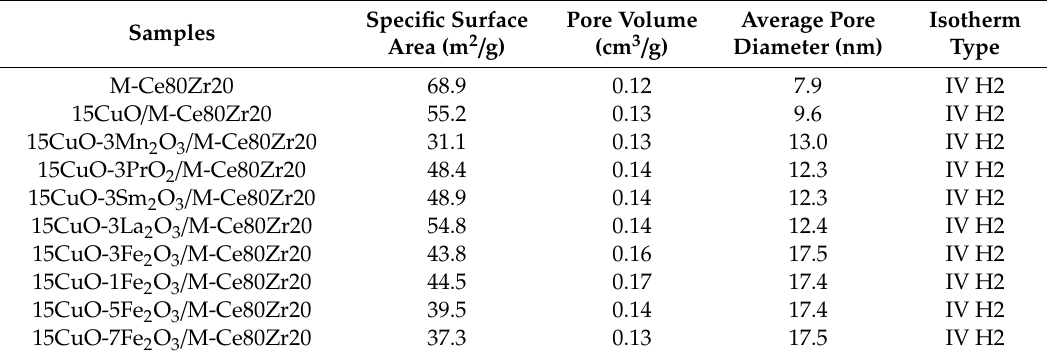
Table 1. Textual properties of M-Ce80Zr20 catalytic support and